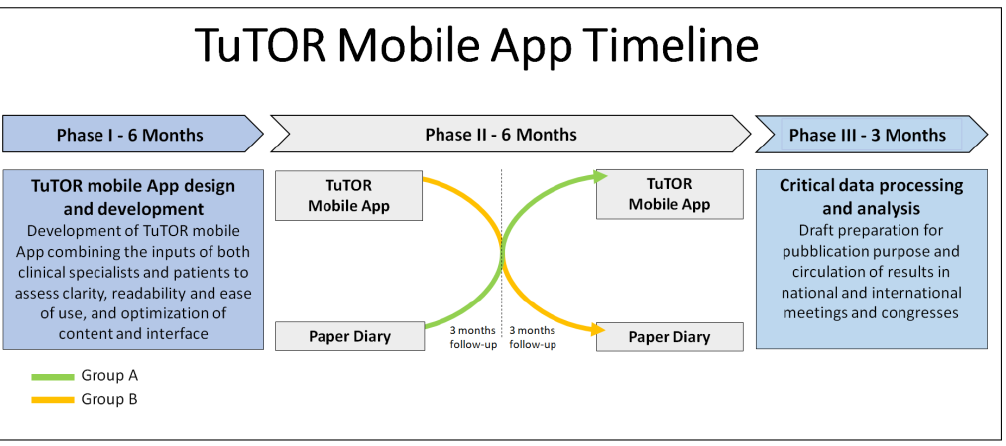
Figure 1. Timeline of the research protocol of the study.